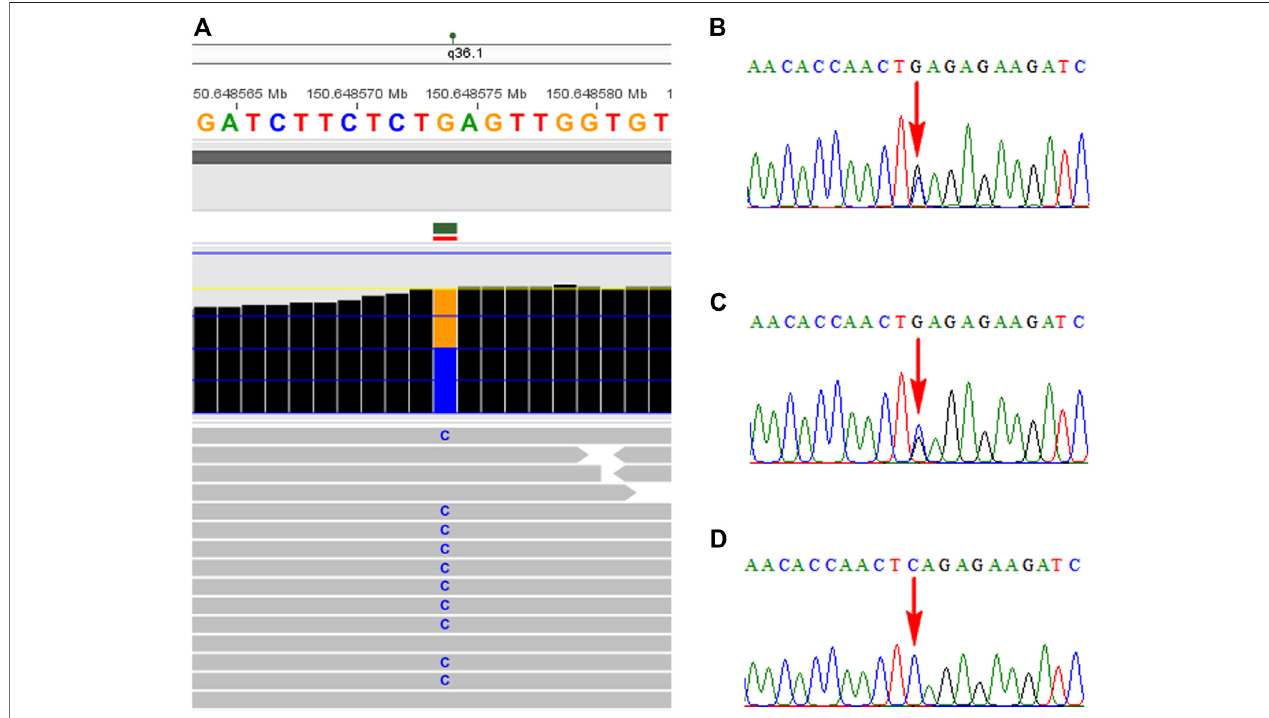
FIGURE2| Identi fi cationofthe KCNH2 mutationinthefamilyusingtheWEStechnologyandSangersequencing. (A) Novelnonsensemutationinthe KCNH2 gene wasidenti fi edinthefetus byWES. (B) Mutationofc.1907C > Gwascon fi rmedbySangersequencing. Parental Sangersequencing revealed thather mothercarried the same mutation (C), while the mutation was not found in her father (D) .